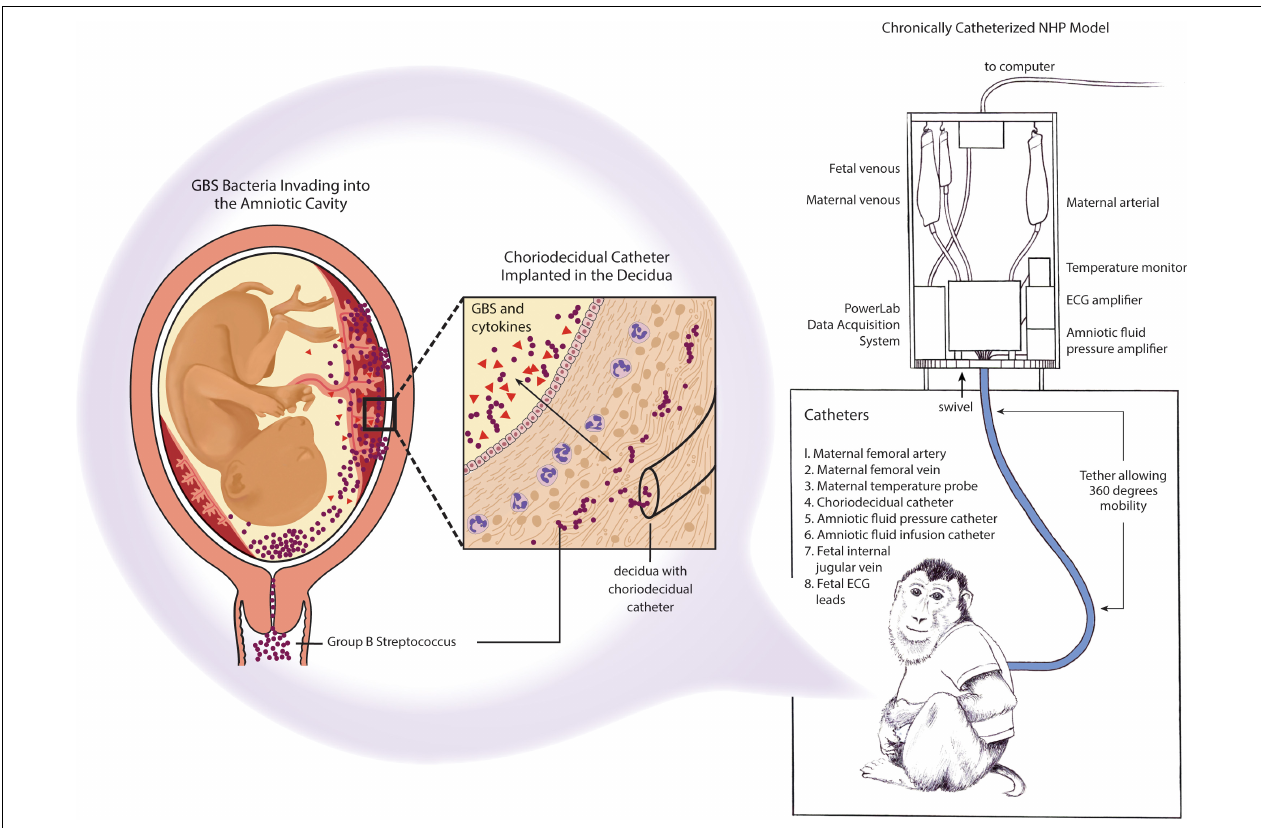
FIGURE 5 | Chronically catheterized pregnant NHP model of GBS infection and preterm labor. Catheters are also inserted into the dam (maternal vein), amniotic fluid to monitor pressure and enable inoculations and into the fetus (fetal vein). ECG leads may also be placed in the fetal chest wall and arm to monitor the fetal heart rate. The choriodecidual catheter is inserted in between the uterus and the chorioamniotic membranes of the lower uterine segment (within the decidua) of the pigtail macaque ( M. nemestrina ). Inoculation of GBS through the choriodecidual catheter in the lower uterine segment simulates an ascending infection of bacteria from the vagina, which is hypothesized to occur in human cases of preterm labor induced by GBS or other